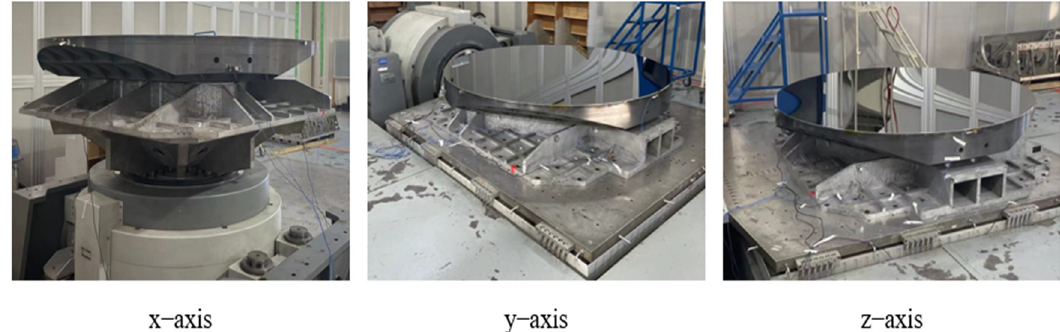
Figure 18. Vibration test.